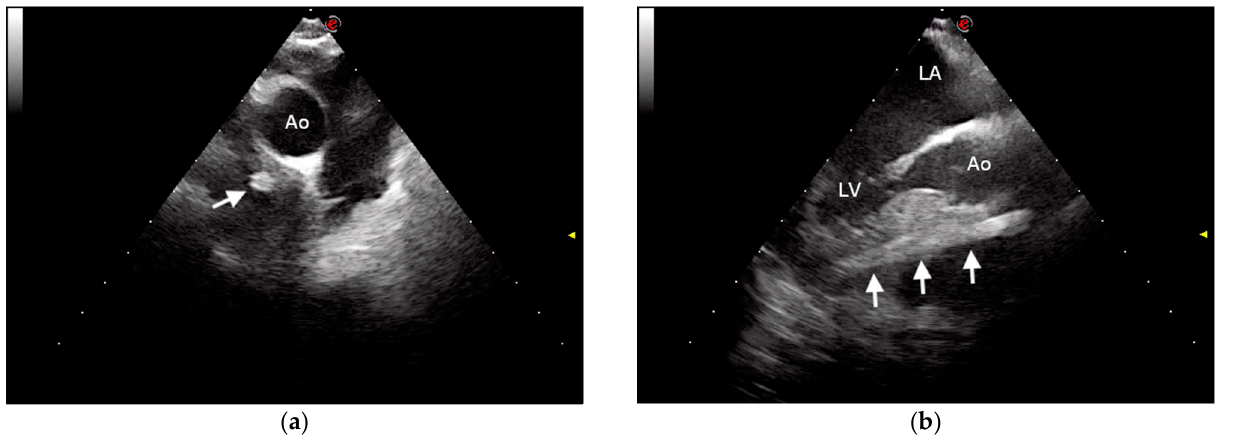
Figure 4. Transesophageal ultrasonographic images of the intramyocardial porcupine quill. ( a ) Transesophageal echocardiographic image of the heart base showing the foreign body as a circular hyperechoic structure (arrow); ( b ) transesophageal echocardiographic image of the left heart chambers and aorta showing the foreign body in its longitudinal plane (arrows). Ao, aorta; LA, left atrium; LV, left ventricle; e, orientation marker.